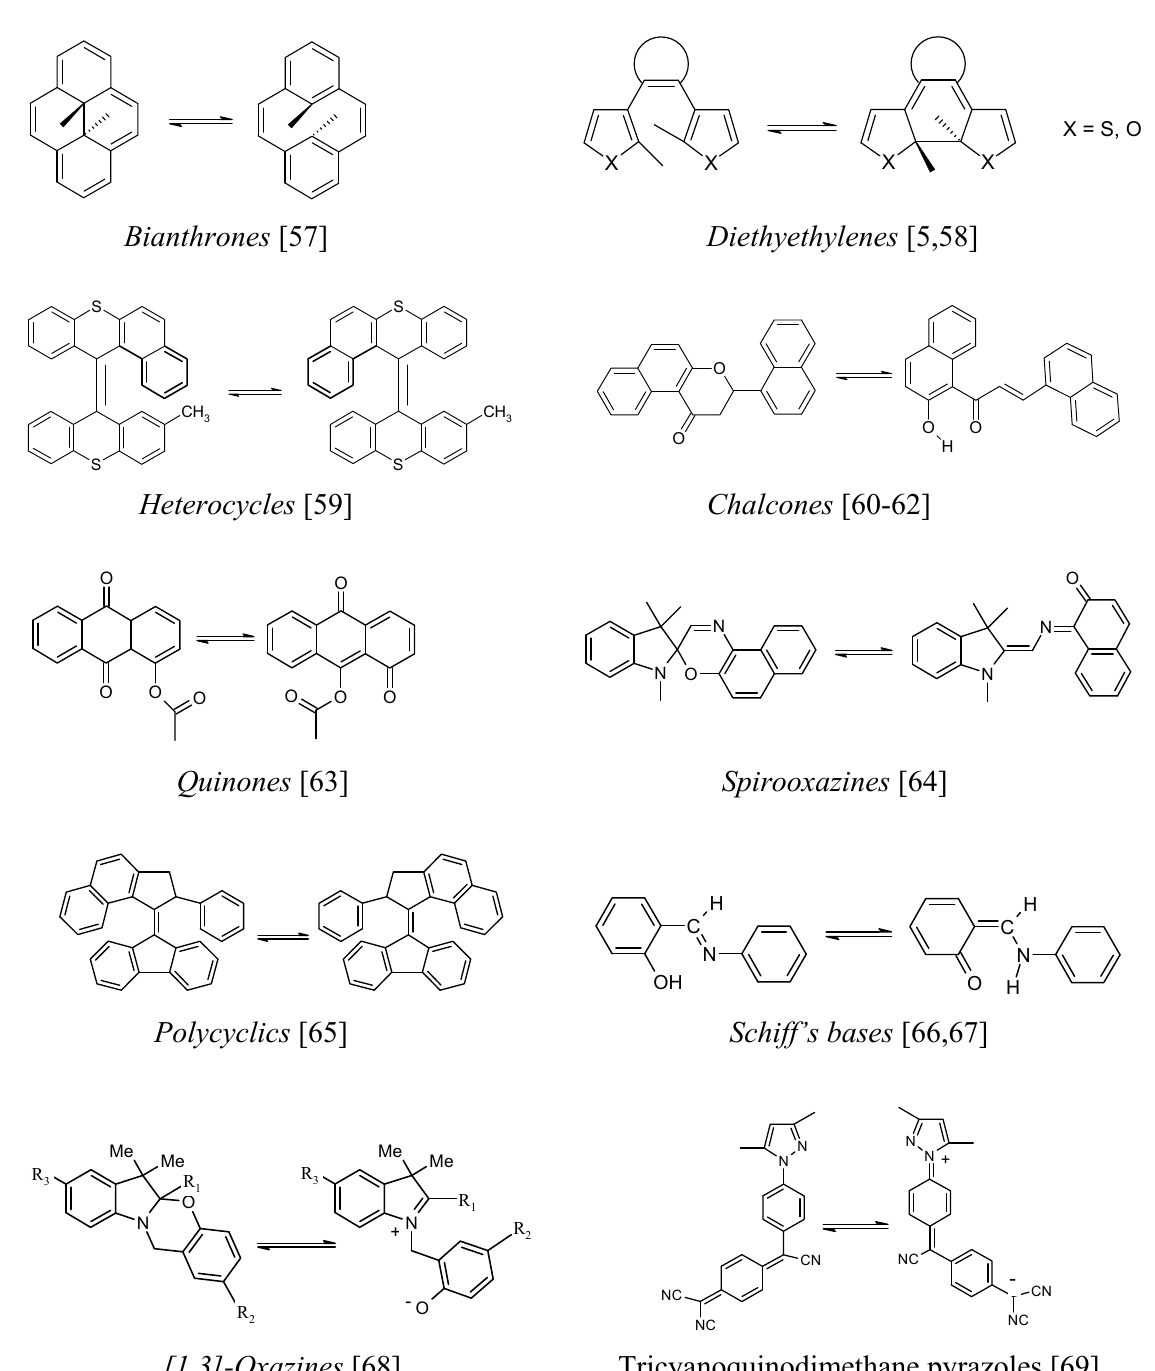
Figure 2. A selection of photochromic and/or thermochromic AB systems possessing a kinetic behaviour similar to that of